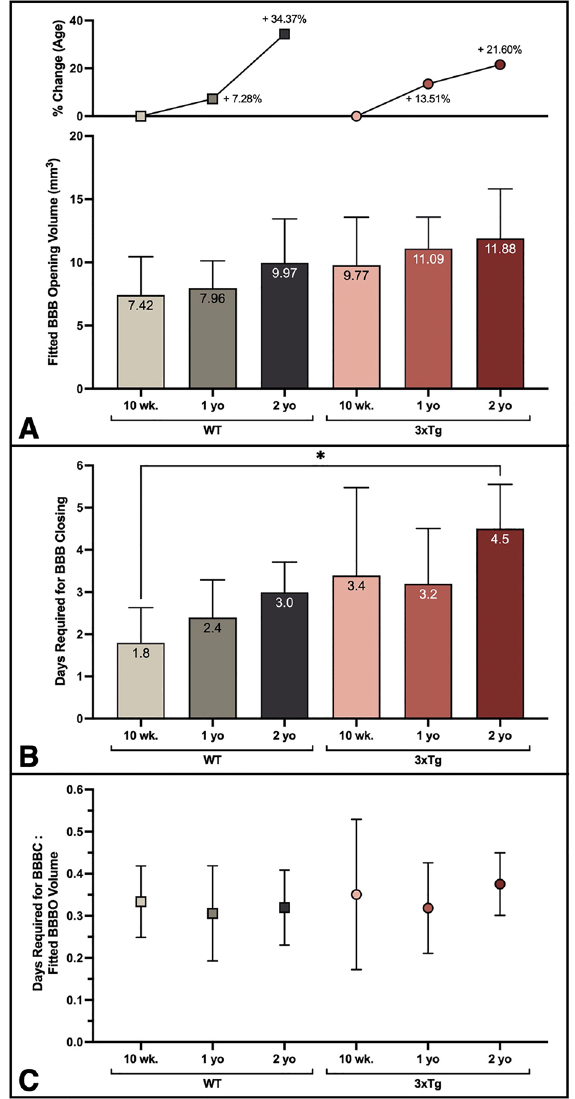
Figure 4. Age and AD elicit trending increase in fitted BBBO and prolonged BBBC timeline. ( A ) The average fitted y-intercept from individual linear regression plots of subjects from each cohort is plotted. The percent change for one- and two-year old cohorts of each genotype compared to the respective 10-week-old cohort is shown in the top plot. ( B ) The average time required for BBB closing following FUS-BBBO is shown for each cohort. ( C ) The ratio of the time required for BBBC to the fitted initial BBBO volume is shown for each cohort. Statistically significant differences are determined by one-way ANOVA with multiple